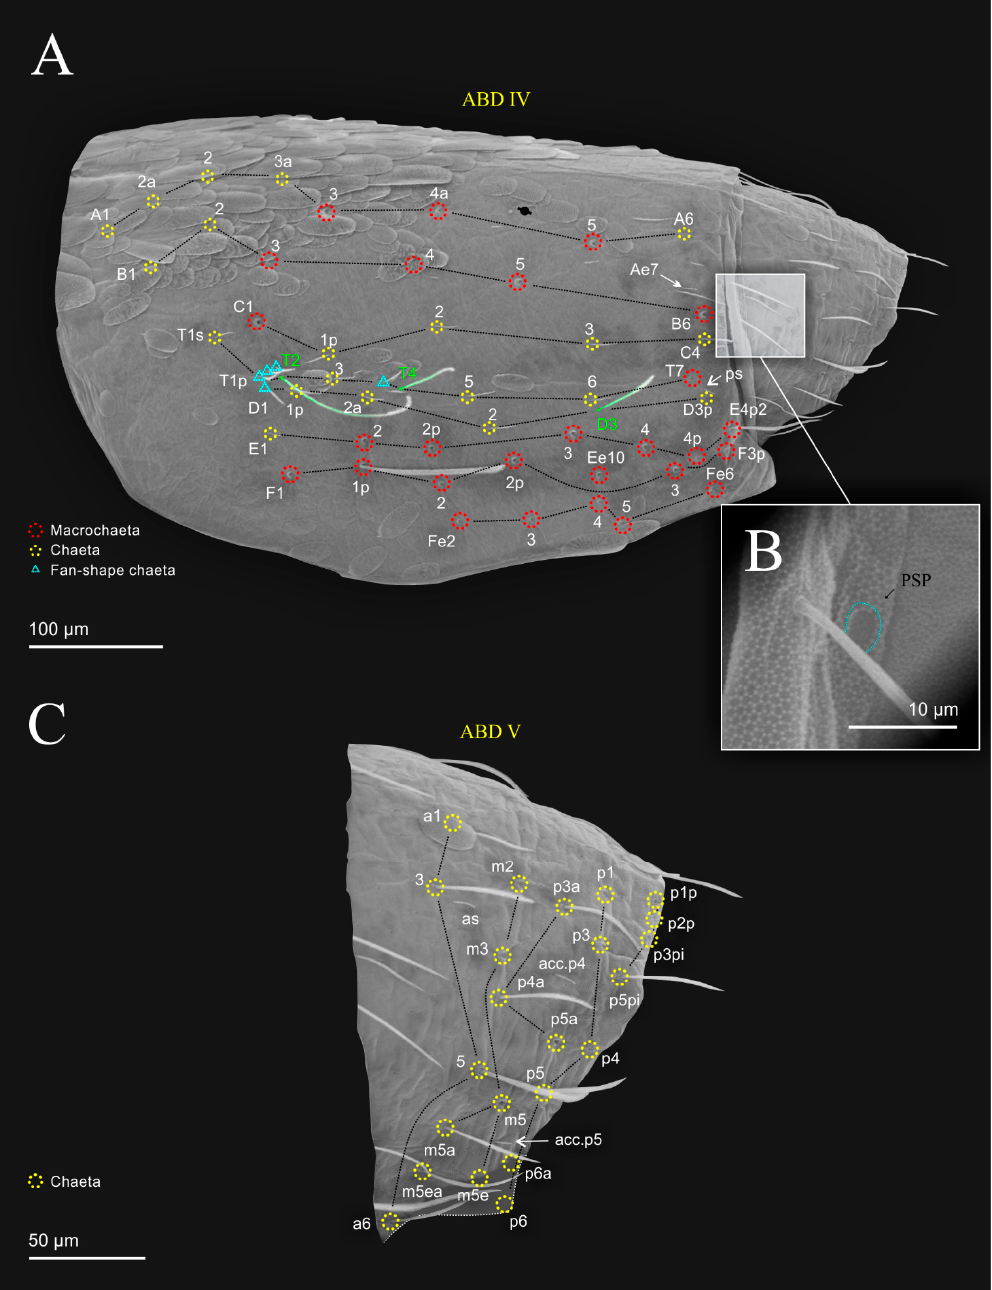
Figure 11. Seira musarum SEM: body chaetotaxy: ( A ), abdomen IV and V, ( B ), pseudopore details; ( C ), abdomen V.